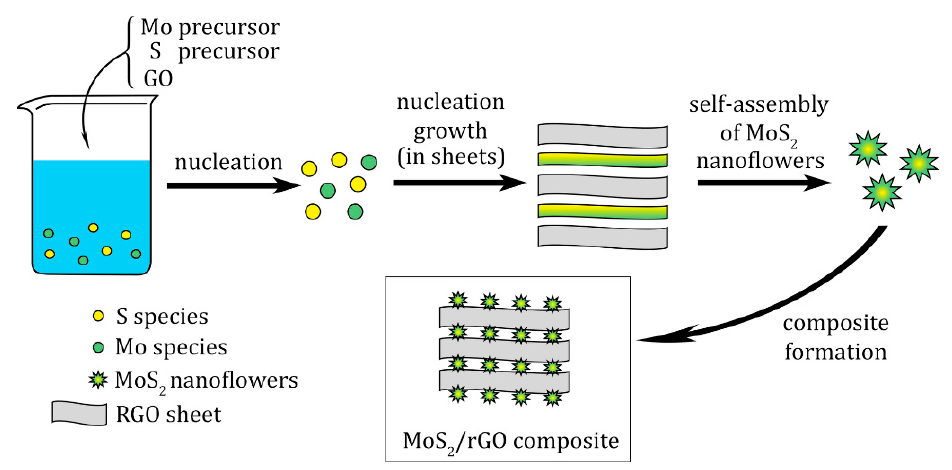
Figure 4. FormationofMoS 2 /rGOcompositesfollowingthethree-stepprocessofhydrothermal synthesis. Figure 4. Formation of MoS 2 /rGO composites following the three-step process of hydrothermal syn- thesis.